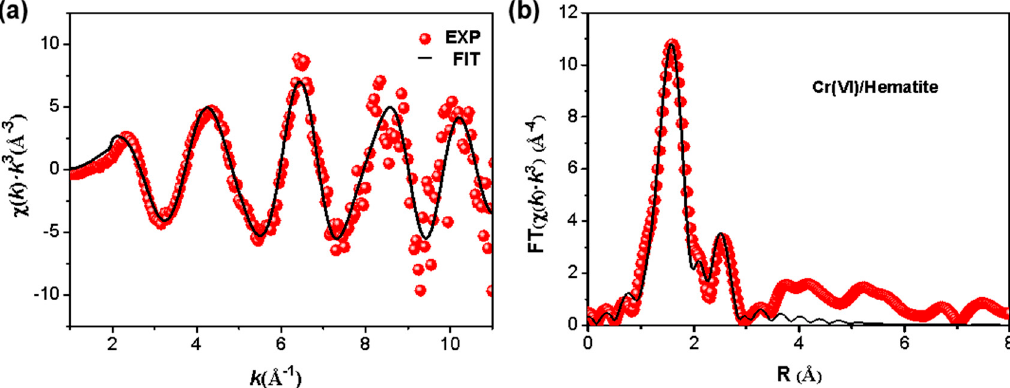
Figure 5. The k 3 -weighted K - edge EXAFS spectra ( a ) of Cr (VI) on hematite show the fit (solid black line) of the theoretical curve to the experimental curve (red spheres). Fourier-transformed spectra ( b ) of Cr (VI) adsorbed on hematite resulting in a radial structure-function. The peak positions correspond to the distances of the atomic shells but are uncorrected for phase shifts.